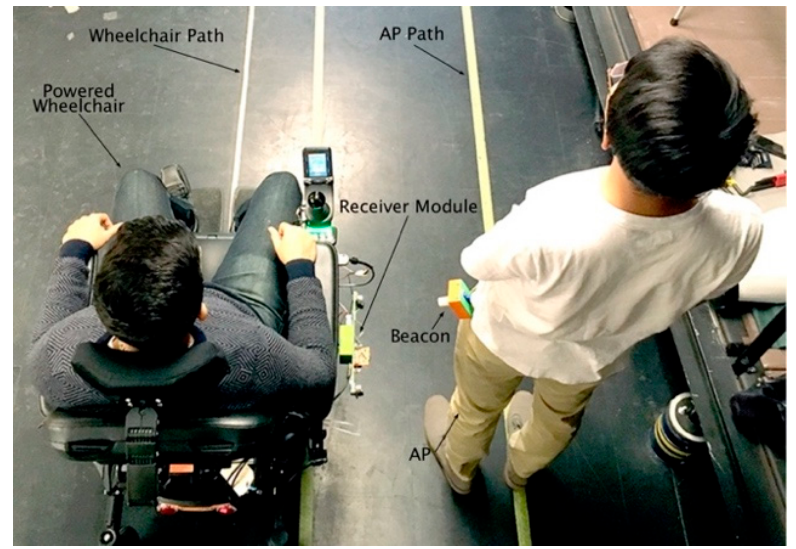
Figure 10. Ultrasonic tethering system performance test setup .